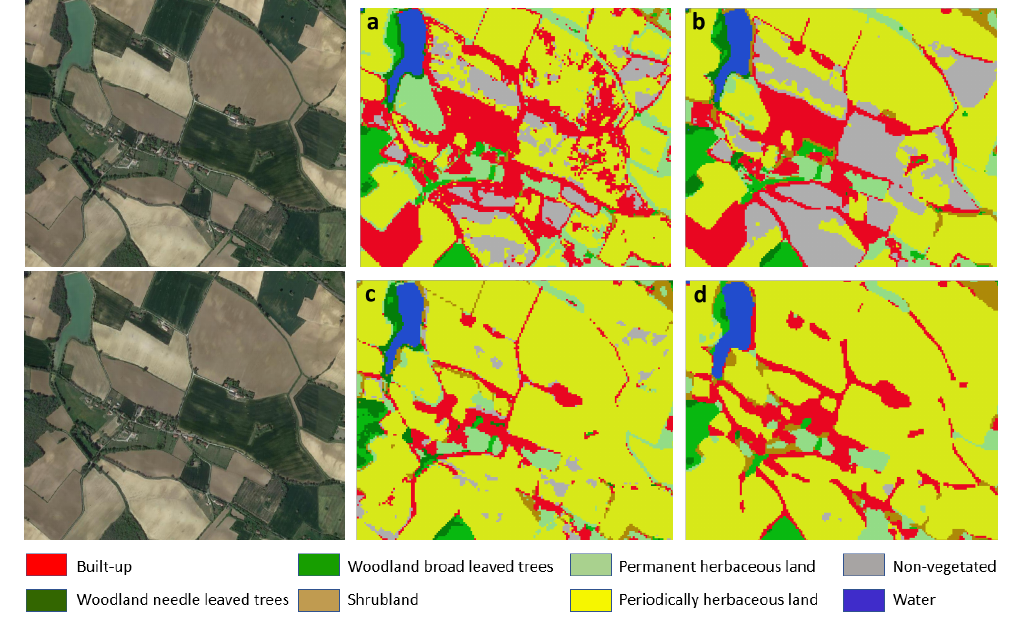
Figure 9. Example of a classified area with presence of crop fields: iota 2 base (a), iota 2 ctx (b), TempCNN (c), 3D-CNN (d). Table 4. Benchmark class F1-scores on validation and test sets. Model reliability is measured by mean F1-scores and standard deviations over 5 trainings. Model efficiency is measured by number of parameters, training and inference on the tile